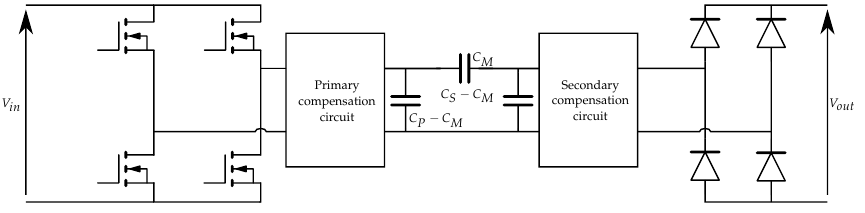
Figure 20. General full-bridge inverter